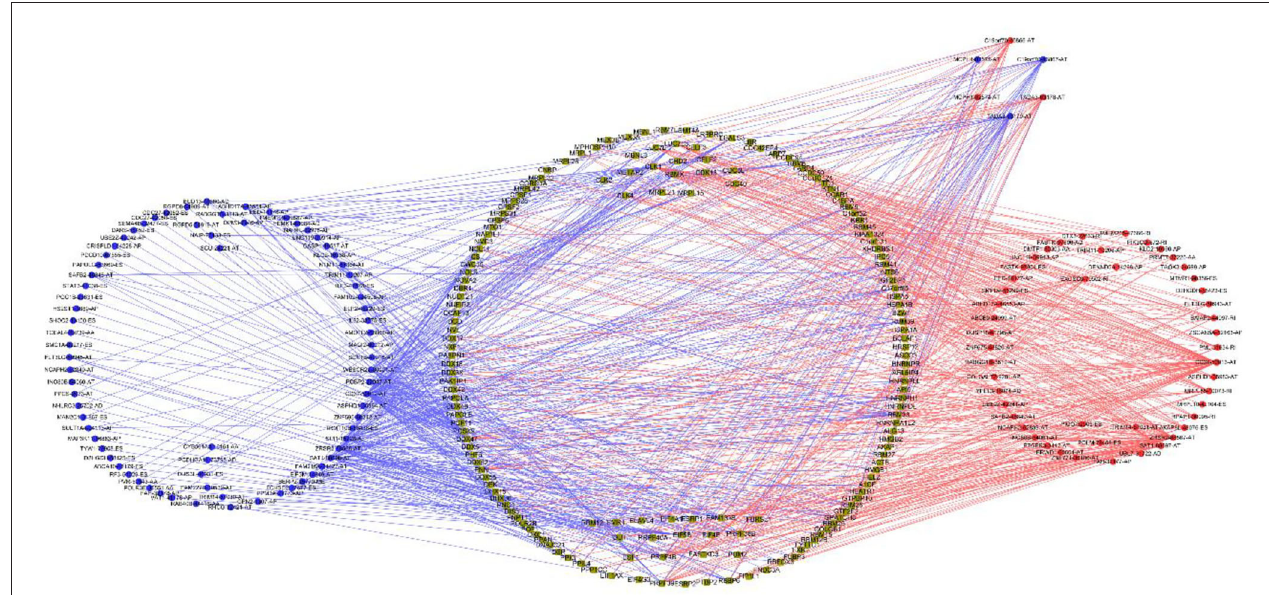
FIGURE 7 | Correlation network of RBPs and OS-ASEs. The yellow dots represent RBPs. The blue and red dots indicate OS-ASEs that have been negatively regulated or positively regulated by the corresponding RBPs. The blue and red lines represent the existence of negative or positive regulation effects. results indicated that RBP mutations were significantly correlated with extensive AS alterations in